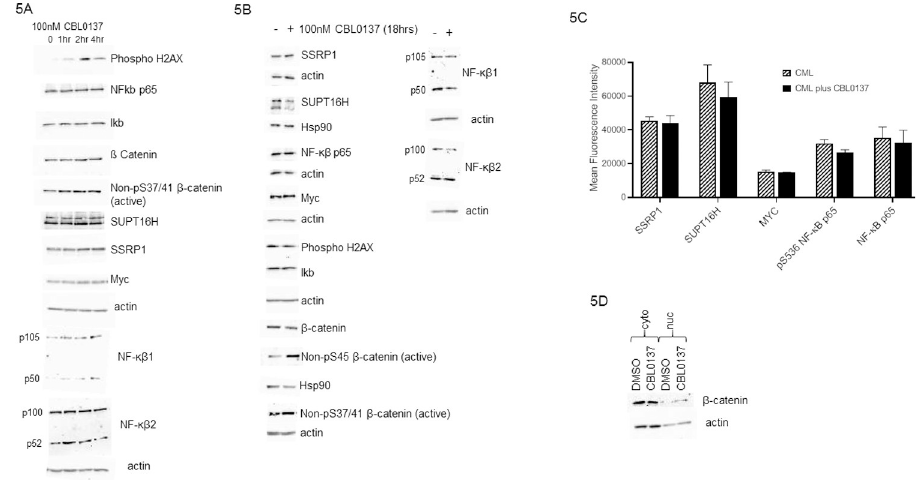
Fig 5. CBL0137 induces β -Catenin activation. Western blot analysis of the proteins indicated in K562 cell lysates following either a four hour time course (Fig 5A) or 18 hour (Fig 5B) treatment with 100nM CBL0137. Fig 5C; CD34 + cells isolated from CML patients were cultured in Fishers media supplemented with 5% Horse serum in the presence or absence of 100nM CBL0137 for 18 hours then stained with the antibodies to the proteins shown and expression levels analysed on a Novocyte flow cytometer (ACEA Biosciences) using FloJo software. Fig 5D; Western blotting analysis of β -catenin expression. K562 cells were treated with 100nM CBL0137 for 18 hours before nuclear and cytoplasmic proteins were